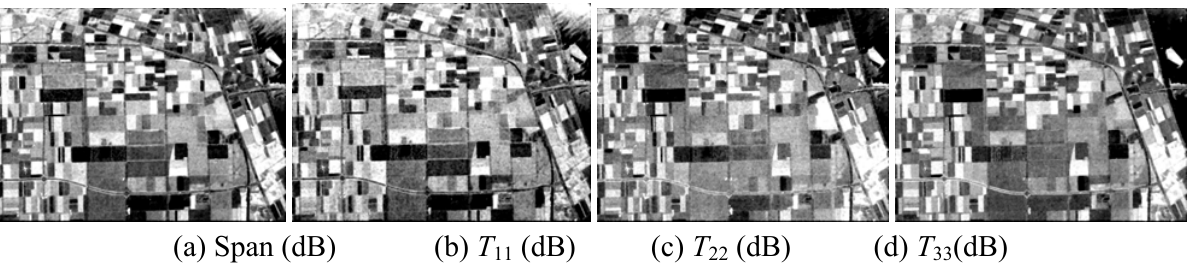
Figure 16. Basic span image and three channels image.